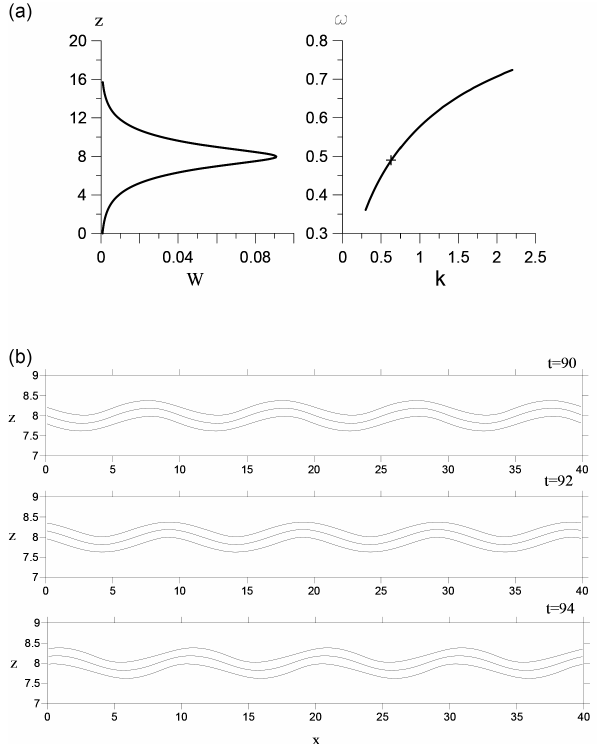
Figure 2. (a) Distribution of the vertical velocity W(z) for wave- length λ = 10 (left) and the dispersion relation ω(k) (right) for the first IW mode. The wave number of the selected wavelength is shown by a symbol. (b) The instantaneous contours of the den- sity deviation obtained in the central ( x,z) plane at different time moments in DNS with initial condition (Eqs. 5–7) prescribed for IW, propagating from left to right with wavelength λ = 10 (fre- quency ω = 0 . 489, phase velocity c ≈ 0 . 78) and amplitude W 0 = 0 . 1. There is no initially induced turbulence. Density contours are 1.3, 1.5 and 1.7. Contour 1.5 marks the location of the pycnocline